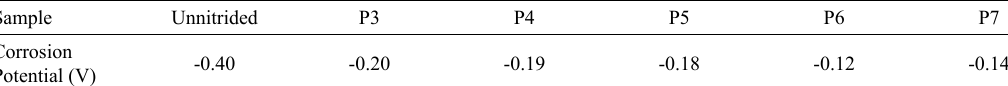
Table 4. Potential corrosion for all the samples.